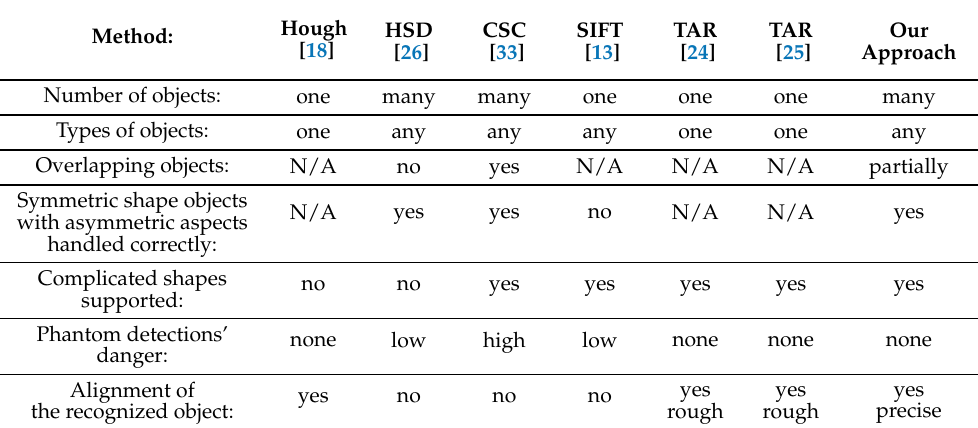
Table 3. Comparison of comparable approaches, concerning the current state-of-the-art. We have qualitatively compared several methods based on the TAR and other shape descriptors. We have considered several features listed in the left column and evaluated their presence or quality of the individual